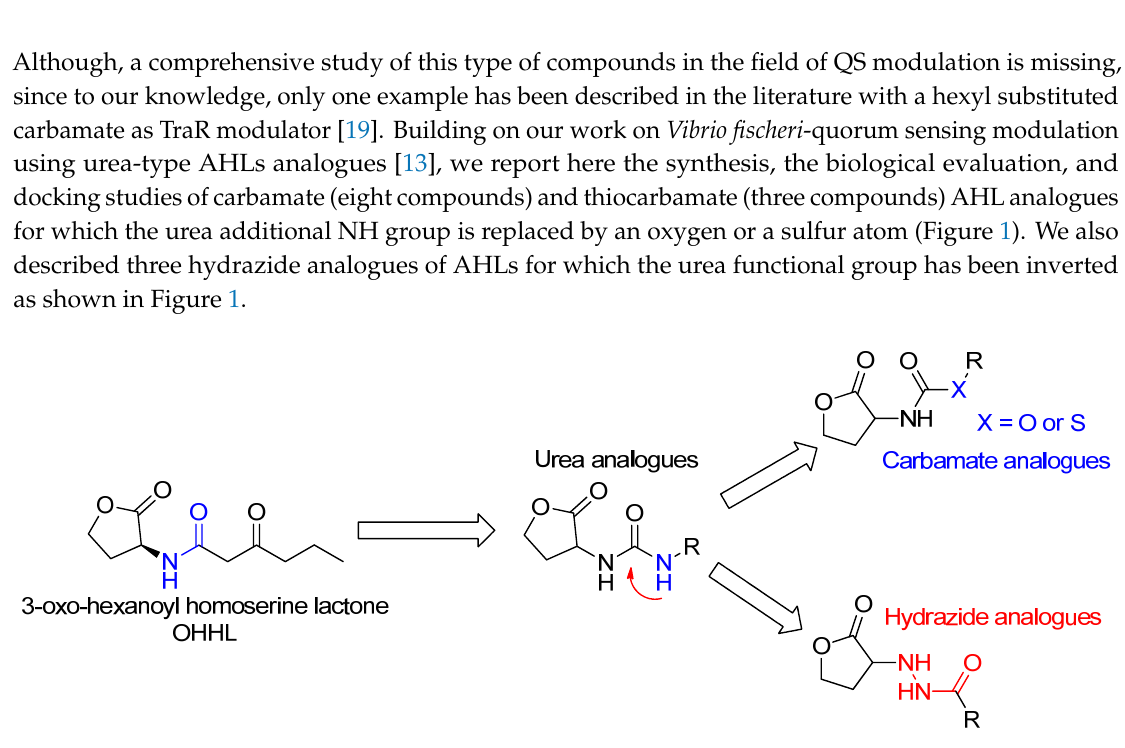
Figure 1. Design of analogues of OHHL modified on the amide functional group.